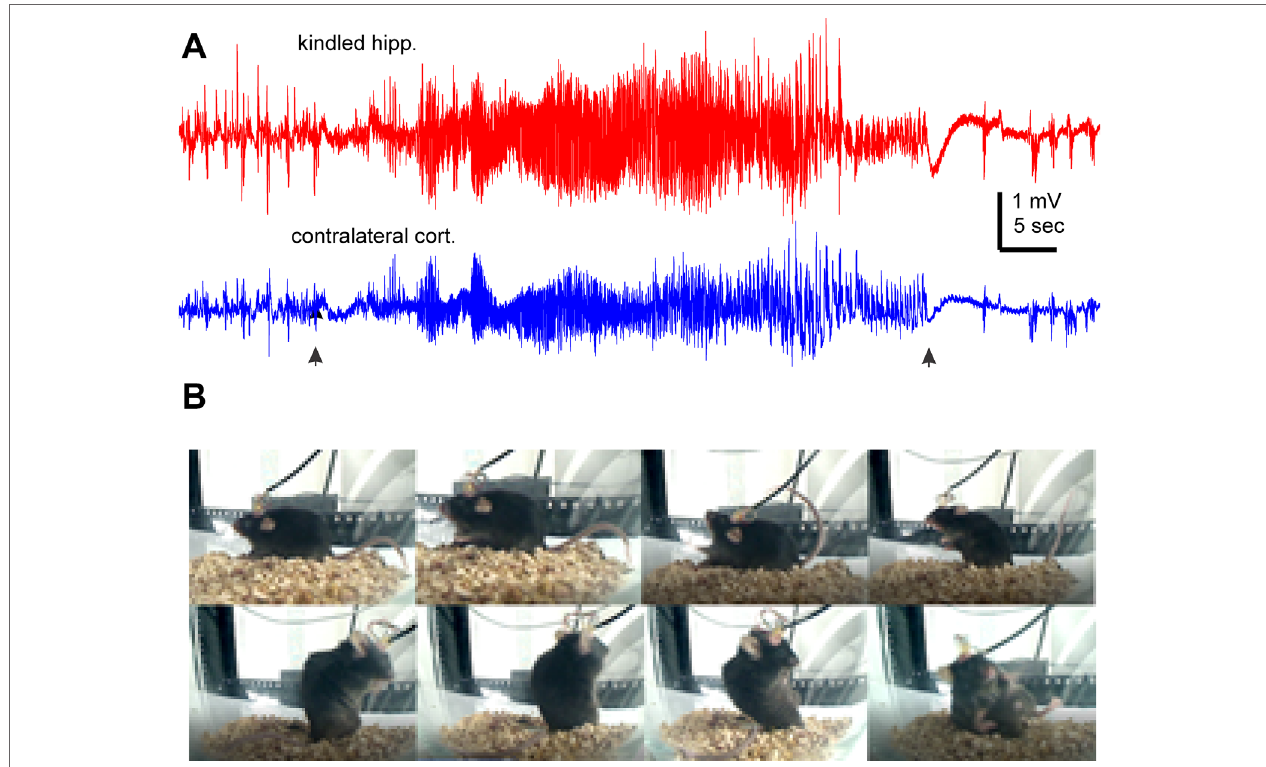
FIGURE 1 | Representative EEG discharges and corresponding motor seizure. EEG traces and images were collected from a mouse the first day after termination of kindling stimulation. (A) Ictal discharges were recorded from of the kindled hippocampus and contralateral parietal cortex. Filled arrows denote the onset and tarnation of discharges. (B) Sequential images (from top-left to bottom right) show a stage-5